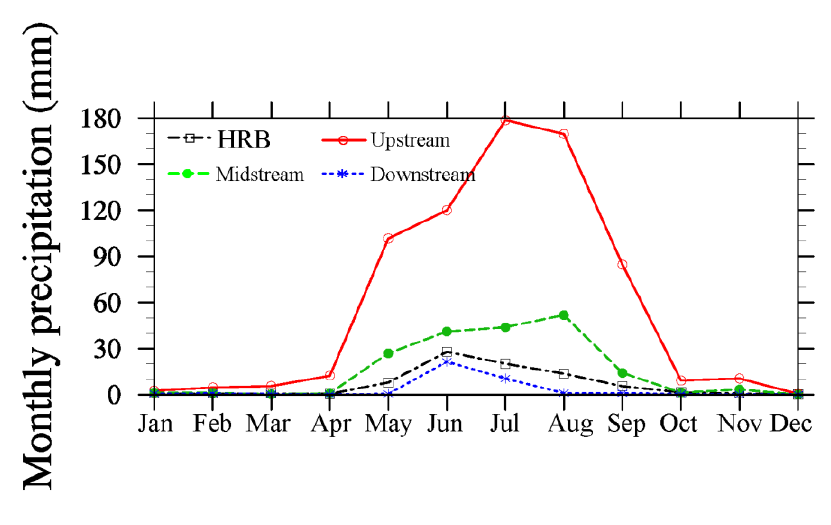
Figure 10. Mean monthly precipitation curves over the HRB and in up-, mid- and downstream areas from 2000 to 2013.